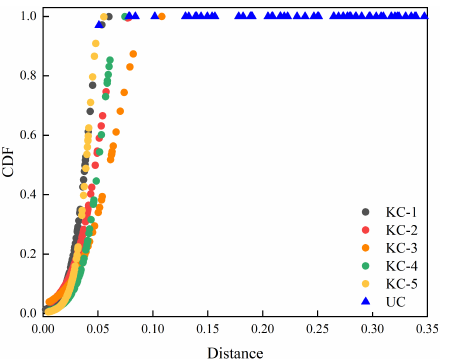
Figure 4. Visualization of the Weibull CDF probability distribution trend for test samples.